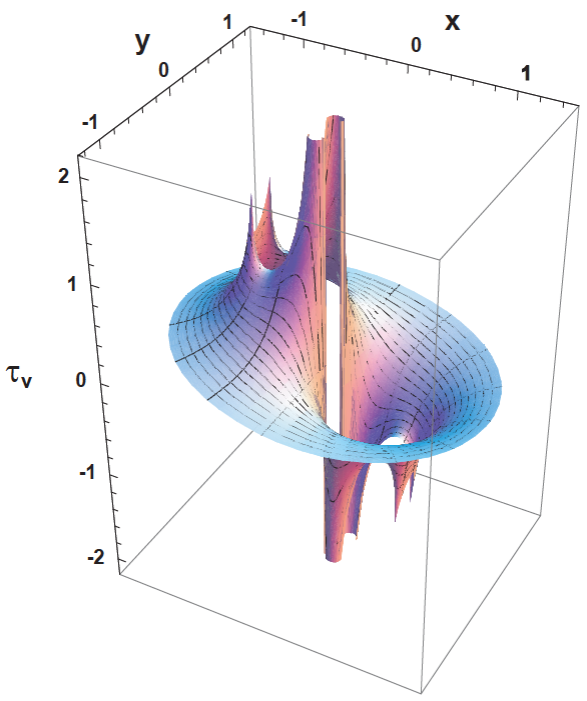
Figure 7: Shear stress for the slot in the